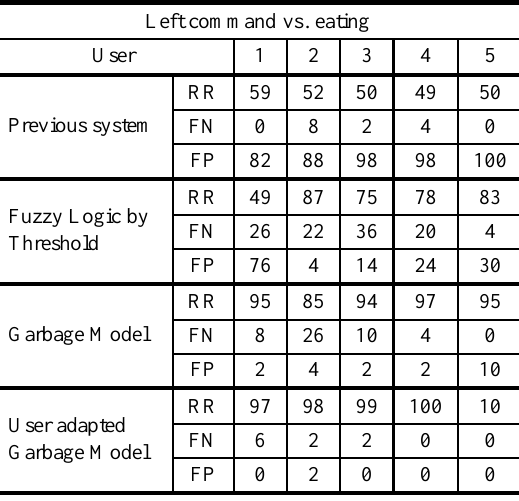
Table 7. Experimental results for ‘left’ command